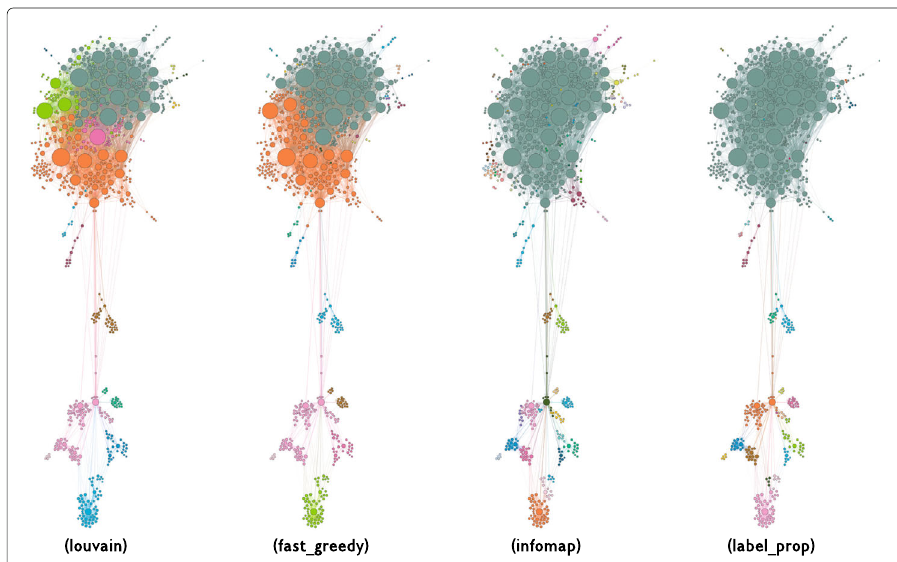
Fig. 6 USairports graph visualisation. USairports graph visualisation. The graph is plotted by means of the force-atlas2 layout with weighted edges, and the size of the vertices reflects their out-degrees. Only the largest connected component of the graph is shown. The visualisations clearly show the block structure that characterises this graph. The vertices in the four visualisations are coloured according to the labels detected applying four community detection algorithms, as described in Table 5. The visualisations are ordered from left to right according to the AIC of the BCCM fitted to observed graph according to the corresponding block structure. From left to right, we see the colours corresponding to the labels obtained from louvain, fast_greedy, infomap and label_propagation detection algorithms respectively. We highlight the fact that the ranking according to AIC corresponds approximately to the ability of the algorithms to detect the separation between high-degree (and low-degree) vertices within the largest cluster, at the top of the visualisations. The reason for this is that within the largest cluster there are clear deviations from what the configuration model predicts, i.e., high-degree vertices tend to connect to each other, and the best BCCMs captures more of these